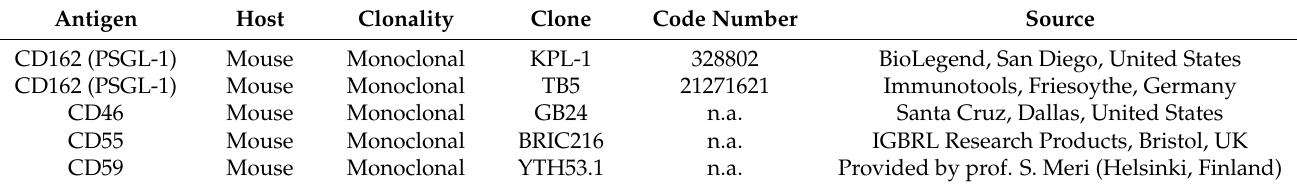
Table 3. Information about the antibodies used in cellular and functional